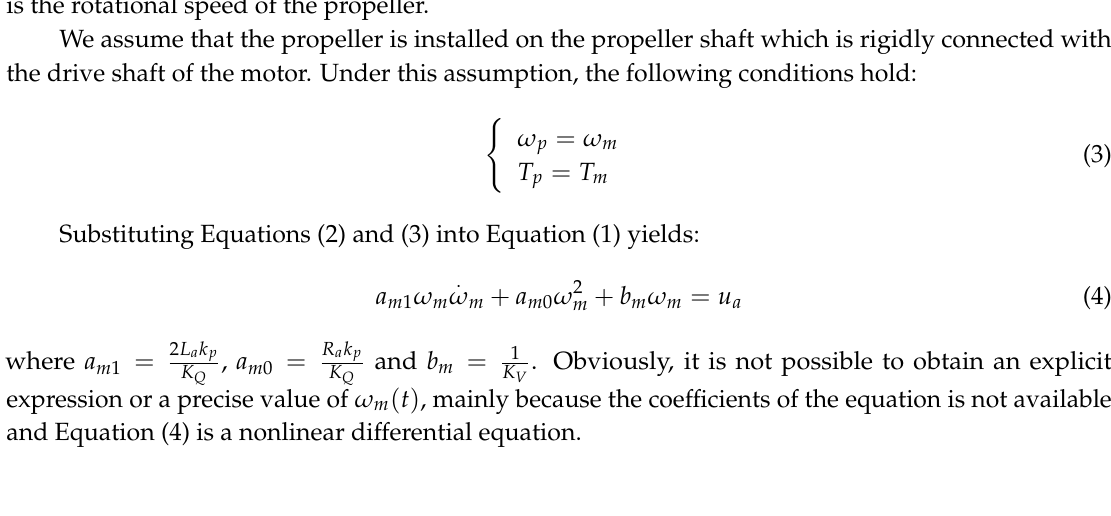
represents torque constant,